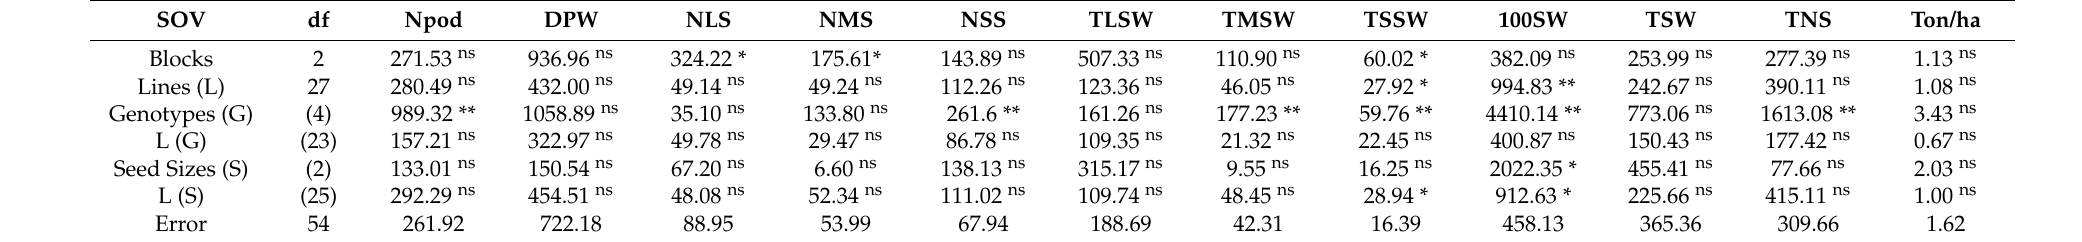
Table 4. Mean squares for the yield traits.